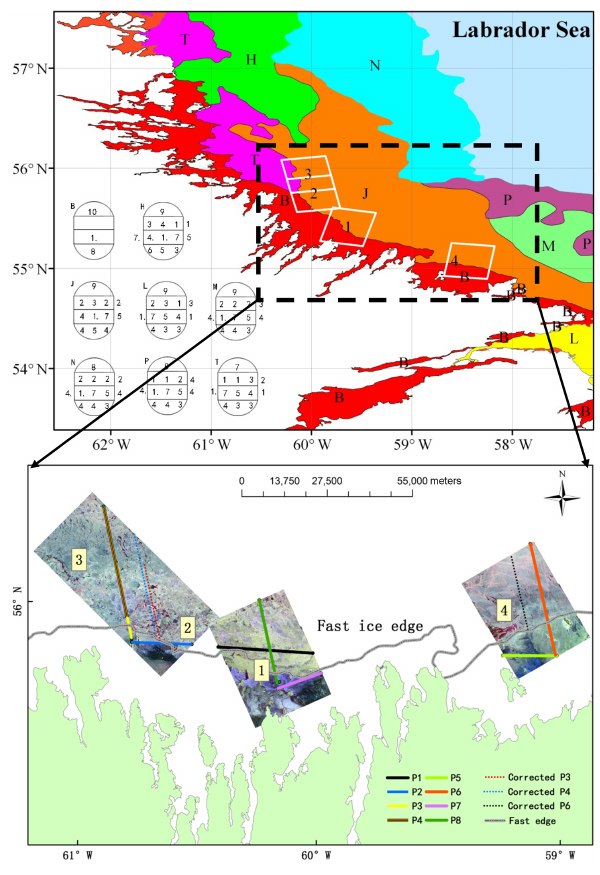
Figure 8. Location of the study site in the Labrador Sea, with Pauli RGB (HH + VV for blue, HH − VV for red, and HV for green) de- compositions of the RADARSAT-2 images © MDA. The specifica- tions of the SAR data used are given in Table 3.